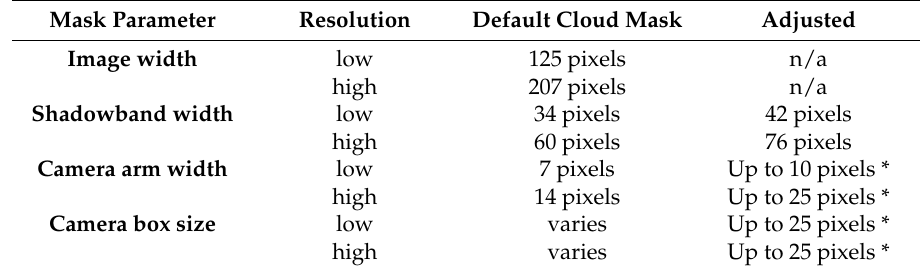
Table A1. Expansion of the non-sky regions of the TSI cloud mask prior to image interpolation. Mask Parameter Resolution Default Cloud Mask Adjusted Image width low 125 pixels n/a high 207 pixels n/a Shadowband width low 34 pixels 42 pixels high 60 pixels 76 pixels Camera arm width low 7 pixels Up to 10 pixels * high 14 pixels Up to 25 pixels * Camera box size low varies Up to 25 pixels * high varies Up to 25 pixels *